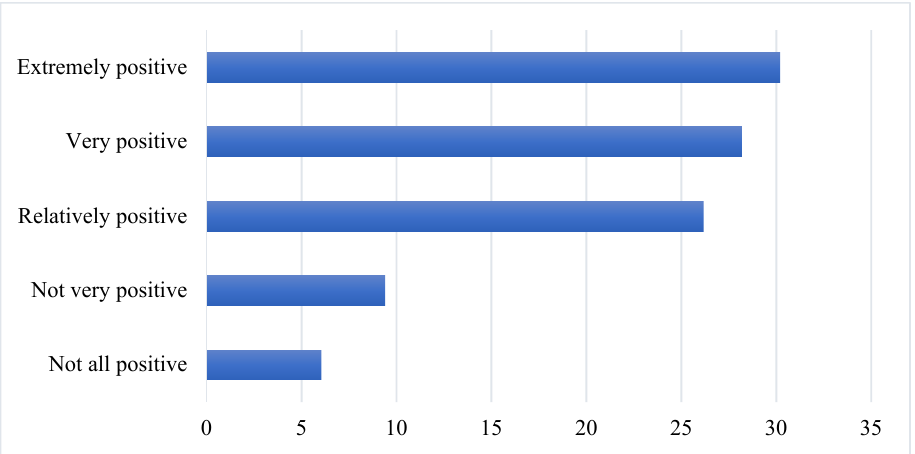
Figure 10. TripAdvisor’s contribution toward firm success (%).